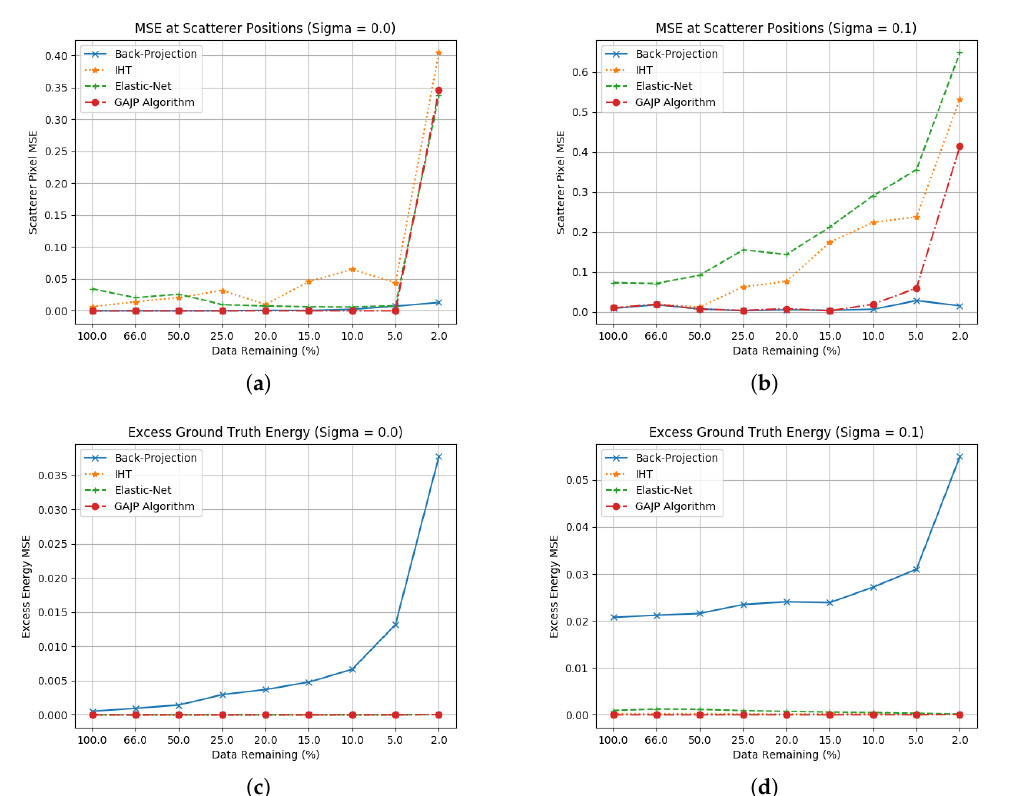
Figure 12. Ground truth estimation statistics for the new processing chain against 20 randomly-placed scatterers. ( a ) Scatterer location RCS error without noise; ( b ) Excess energy without noise; ( c ) Scatterer location RCS error including noise ( σ = 0.1); ( d ) Excess energy including noise ( σ =